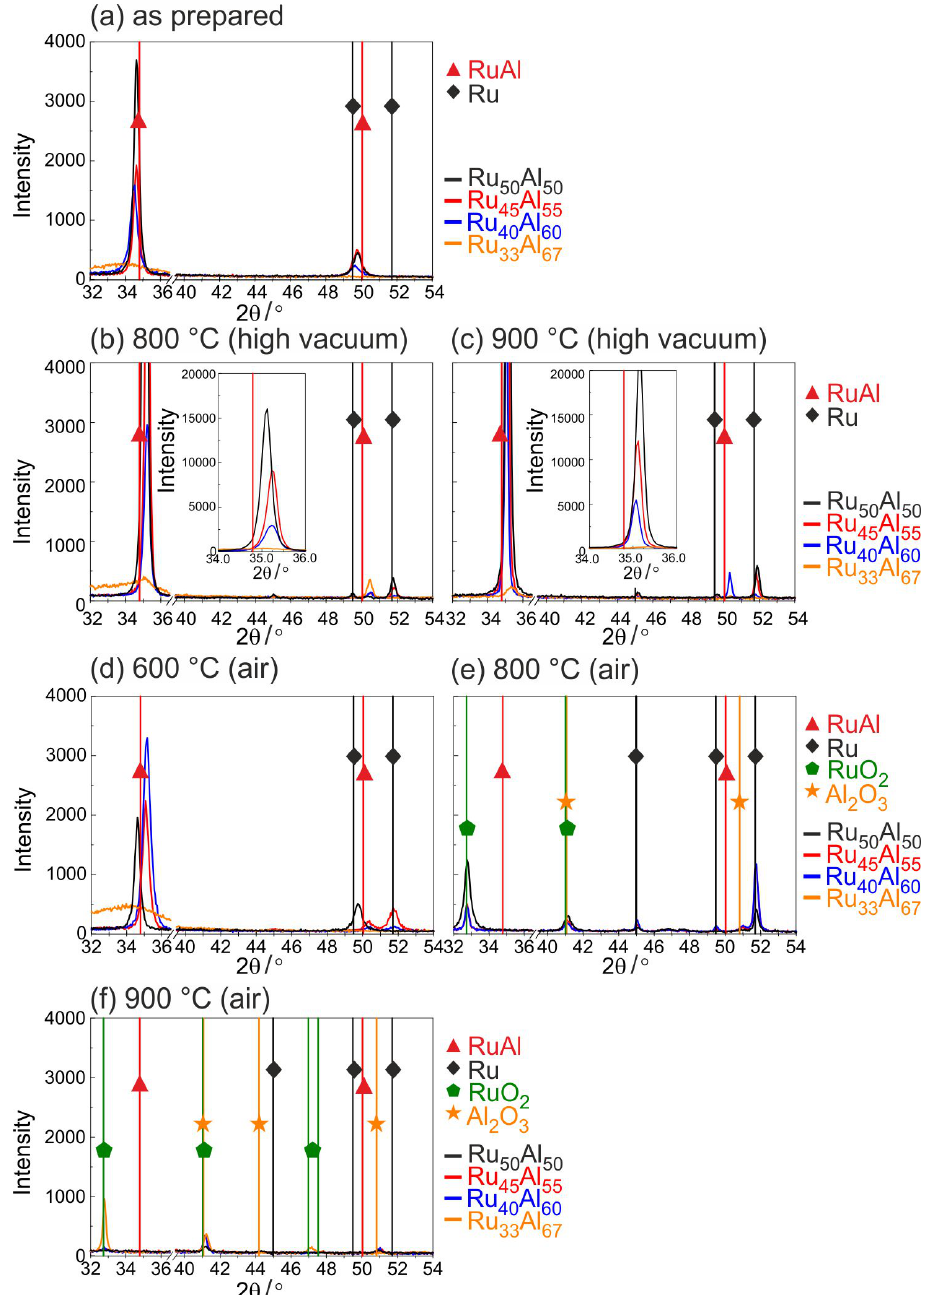
Figure 1. X-ray diffraction (XRD) measurements (CoK α ) of samples with the different compositions Ru 100– x Al x ( x = 50,55,60,67) ( a ) after preparation and after heat treatment for 10 h at ( b ) 800 ◦ C under high vacuum; ( c ) 900 ◦ C under high vacuum; ( d ) 600 ◦ C in air; ( e ) 800 ◦ C in air and ( f ) 900 ◦ C in